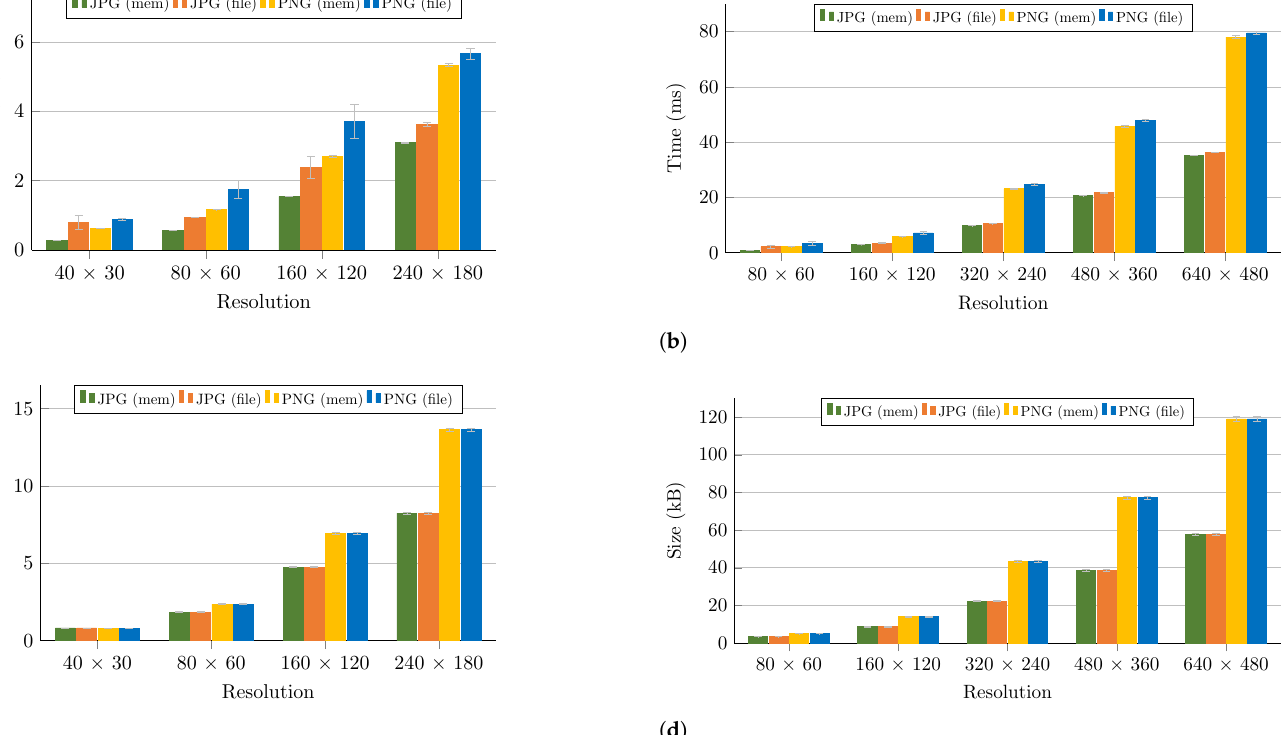
Figure 20. ( a ) Time to compress a grayscale acoustic heatmap for different resolutions and ( c ) the corresponding size of the compressed image (mode 1). ( b ) Time to compress an RGB image for different resolutions and ( d ) the size of the compressed image (mode 3, 4 and 5). The gray lines indicate the confidence